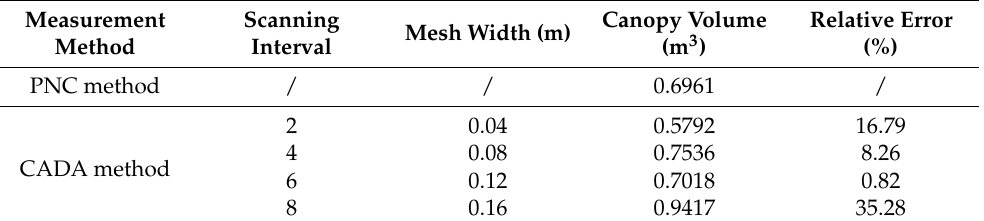
Figure 8. Tree 1 canopy contour point cloud restoration. Table 4. Effect of the mesh width on the canopy volume measurement.